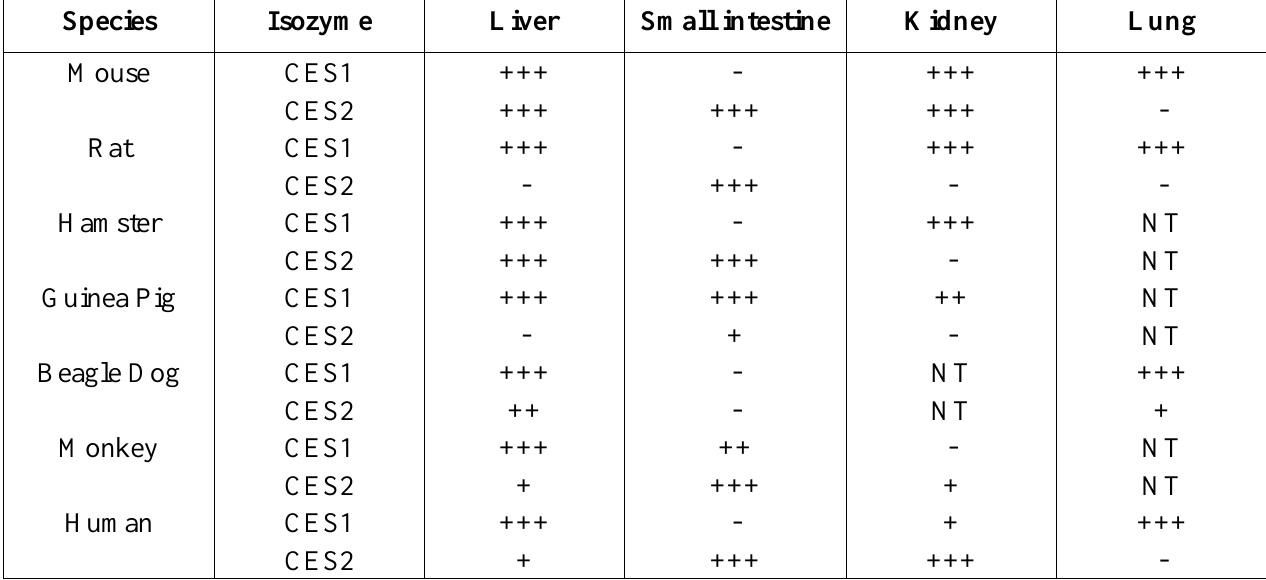
Table 2 . Tissue-specific expression profile of CES1 and CES2 isozymes in mammals and